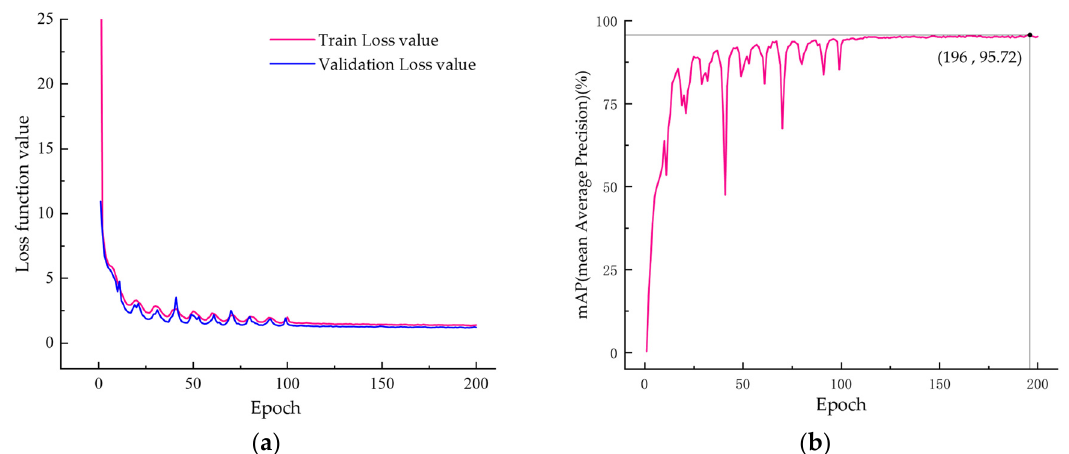
Figure 10. Network training results: ( a ) Training and validation loss curves; and ( b ) mAP in the test set.